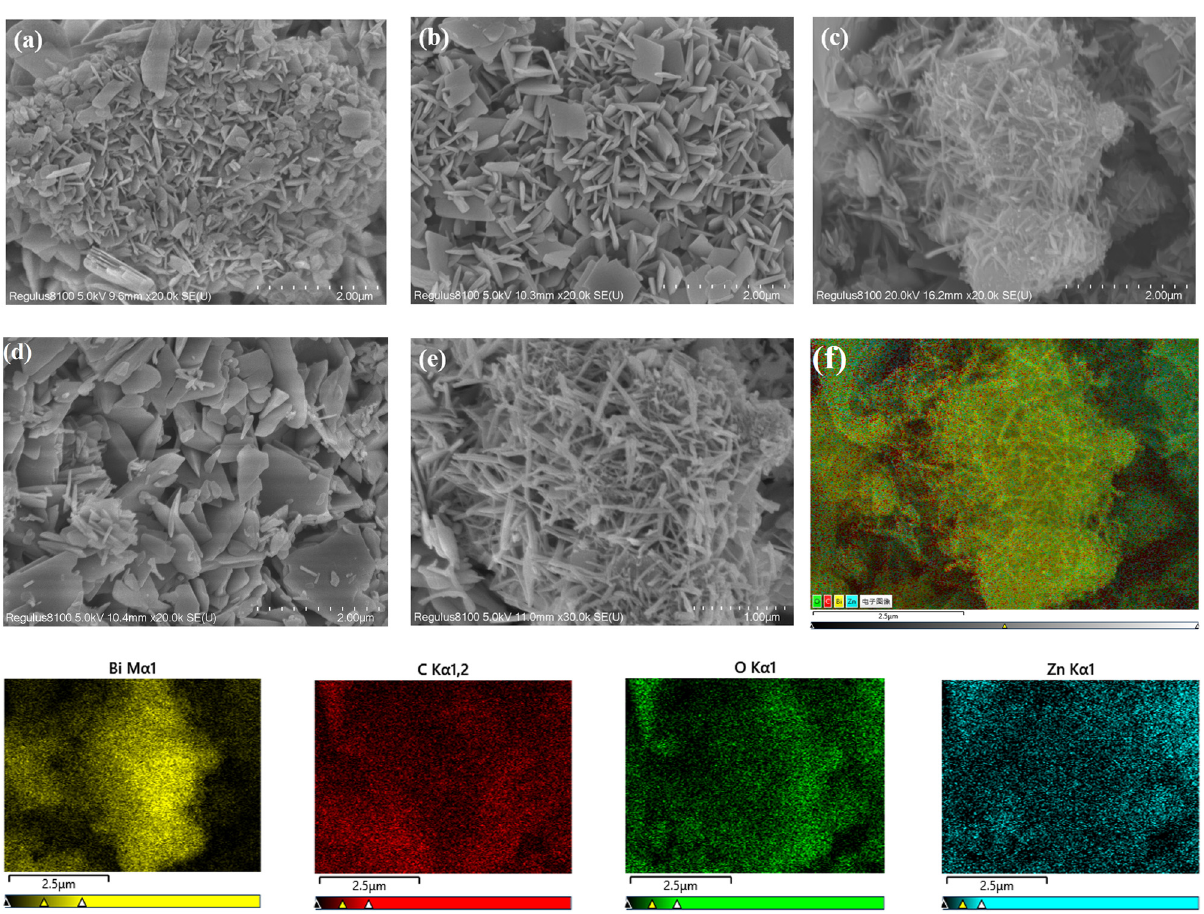
Figure 2: SEM images of Zn - MOF ( a ) , Bi 2 O 3 @Zn - MOF - 1 ( b ) , Bi 2 O 3 @Zn - MOF - 2 ( c and e ) , and Bi 2 O 3 @Zn - MOF - 3 ( d ) , and ( f ) the EDX analysis of Bi 2 O 3 @Zn - MOF - 2 sample and the related elemental mapping photographs of Bi, C, O, and